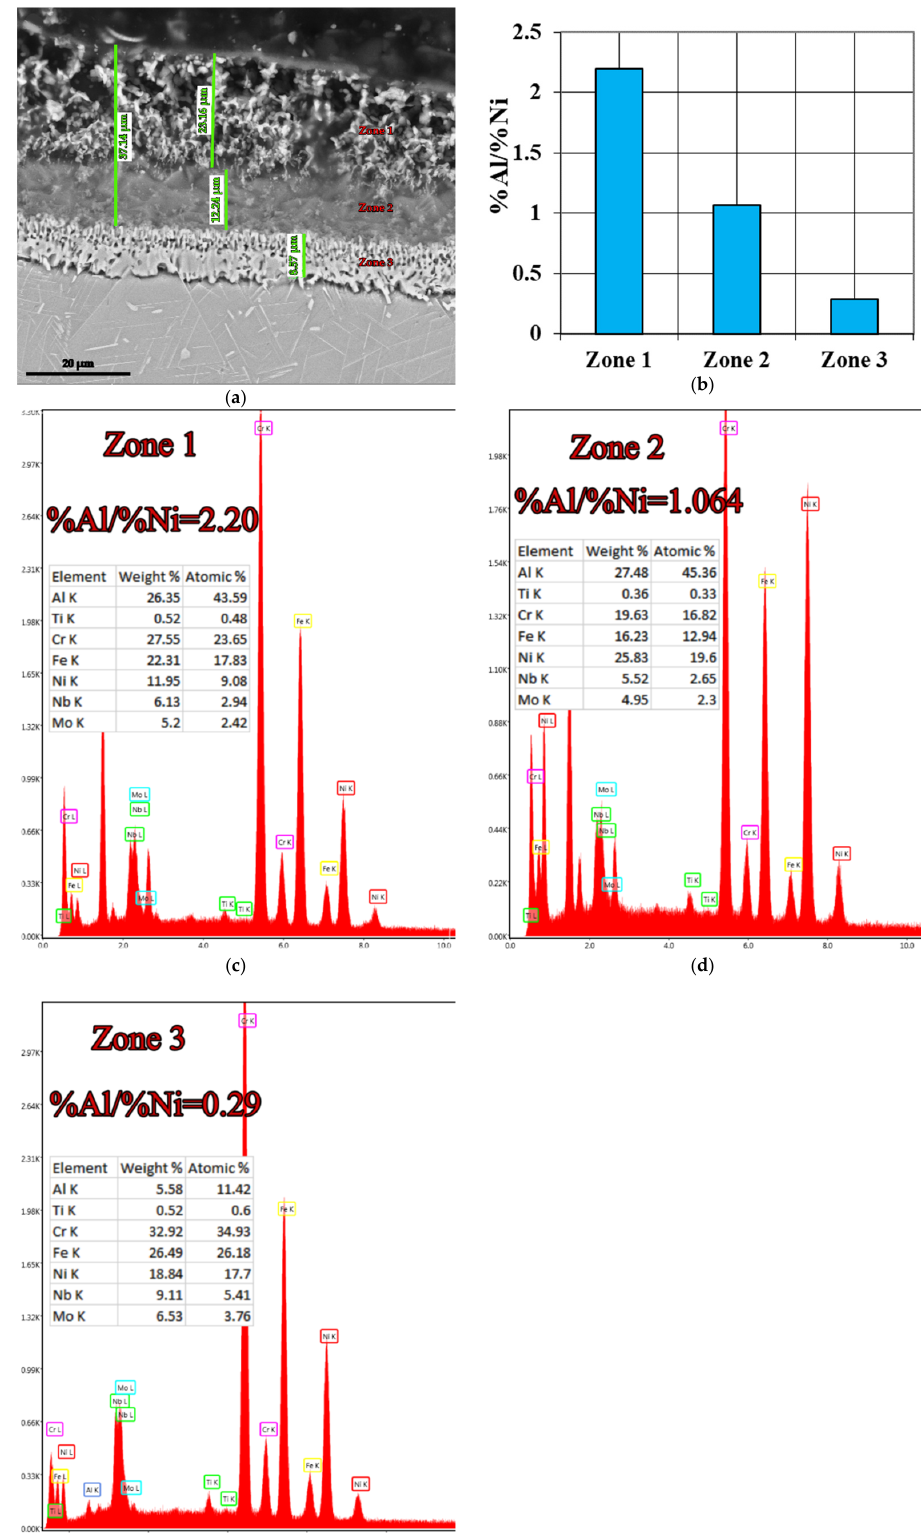
Figure 7. Aluminized Inconel 718 superalloy at 900 ◦ C for 5 h, in a pack aluminizing mixture (98 wt.% FeAl40 + 2 wt.% NH 4 Cl) ( a ); %Al/%Ni weight proportion ratio variation in the investigated zones ( b ); SEM-EDS spectra corresponding to the different zones investigated ( c – e